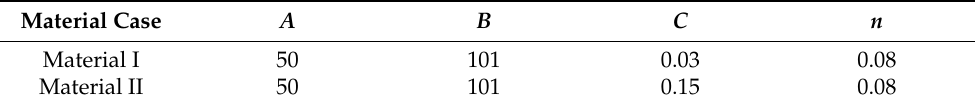
Table 2. J–C model parameters for bone.